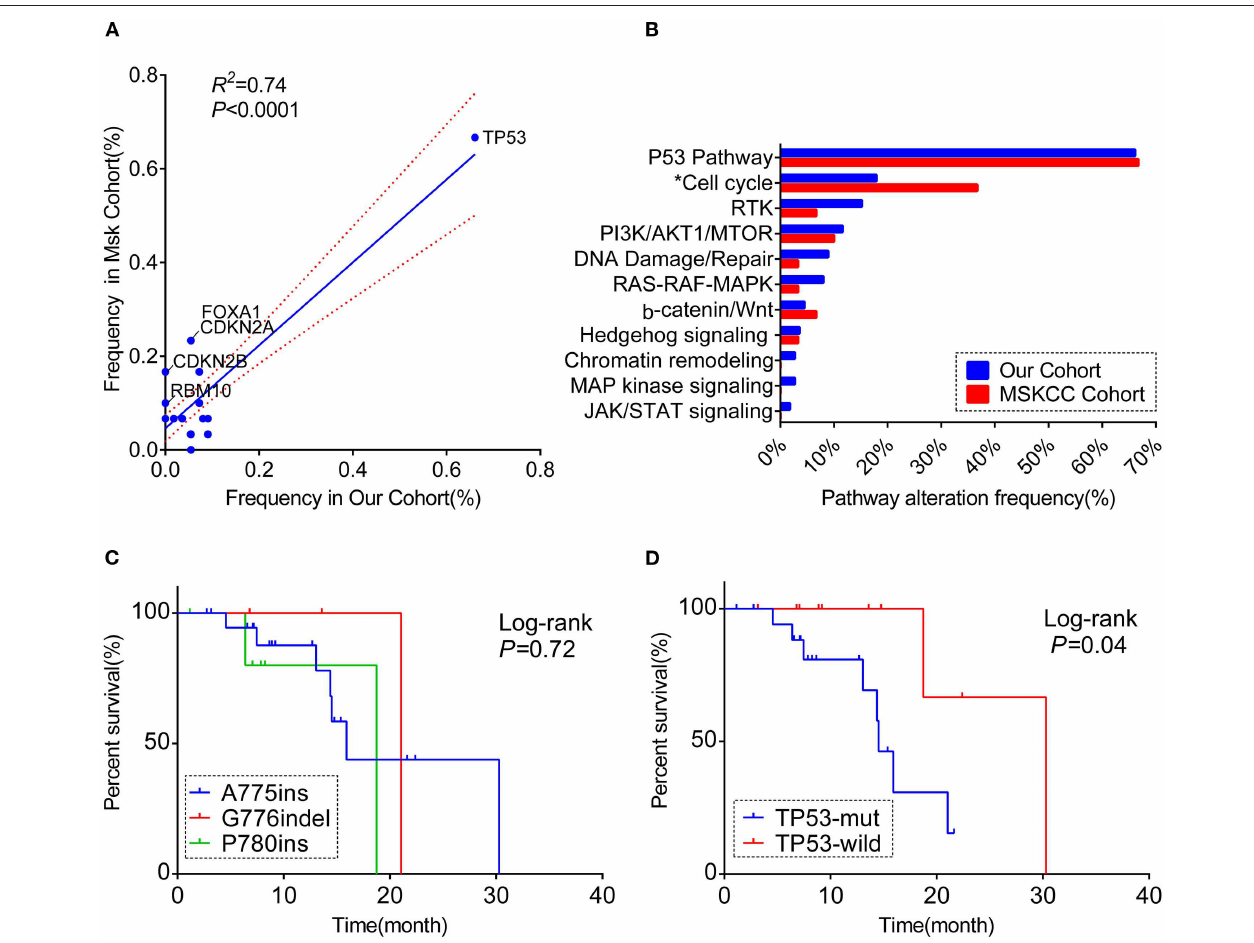
FIGURE 2 | A comprehensive comparison of the co-occurring profile between our cohort and MSKCC cohort for the frequency of (A) totally matched 28 genes (the genes included in the analysis were matched in both cohorts’ panel with the frequency over 5%; the genes labeled are significantly different between the two cohorts). (B) Pathway enriched (Only genes included in 59-gene panel were analyzed; *the pathway significantly different between the two cohorts). RTK, receptor tyrosine kinase/growth factor signaling. (C) Kaplan–Meier curve showing the difference of median overall survival (OS) among patients harboring three different ERBB2 insertion subtypes. (D) Kaplan–Meier curve visualizing the effect of TP53 alteration on